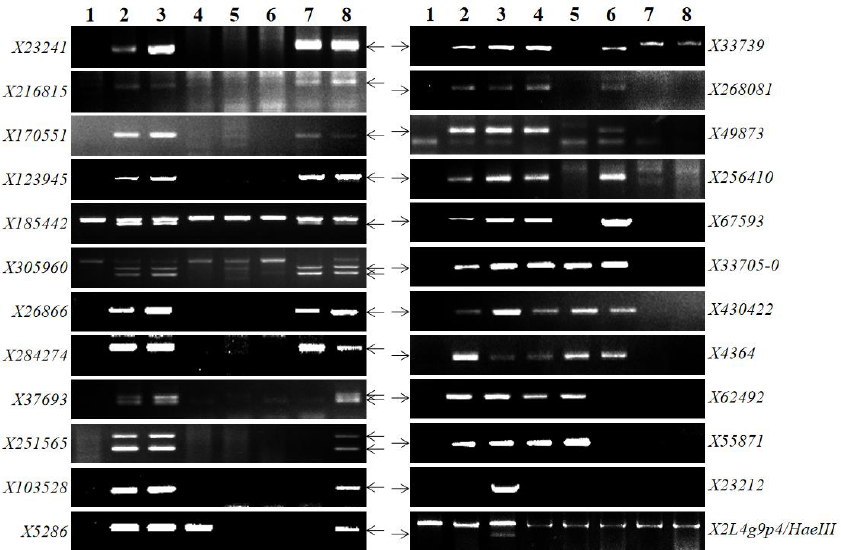
Figure 4. Electrophoresis patterns of 24 molecular markers at 2S s #1 interval locating Pm57 . Lane 1, Bgt -susceptible control CS; 2-3, Bgt -resistant controls 89-88, and 2011-400; 4-6, Bgt -resistant recombinants of CS- Ae . searsii 2S s #1, 88R-1-12-2, 88R-3-19-1, and 88R-5-4-2; 7-8, Bgt -susceptible recombinants 88S-18-3-2, and 88S-17-4-1. Arrows indicate 2S s # 1 specific amplicons.